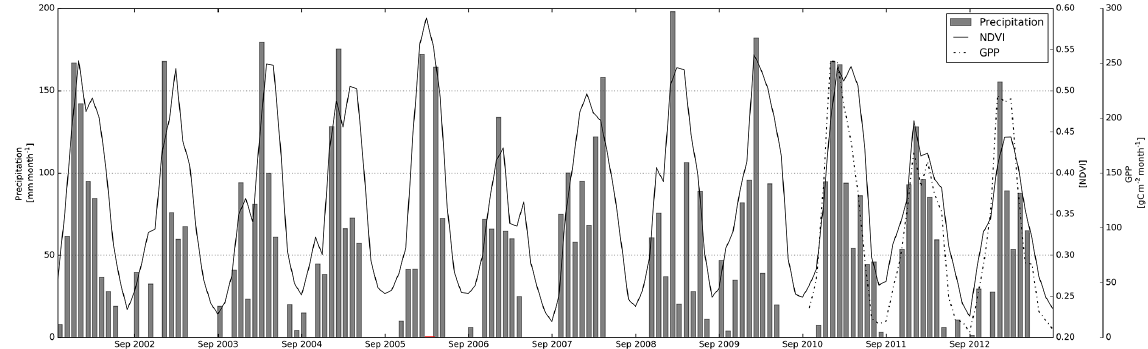
Figure 10. Time series of monthly precipitation (bars), NDVI (solid line) from September 2001 to August 2013 and GPP from September 2010 to August 2013. The precipitation was measured at a nearby weather station (SAWS) in Potchefstroom. The red bar denotes a missing precipitation value in February